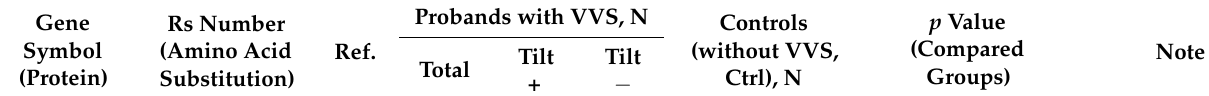
Table 1. Data on the association of polymorphic loci of candidate genes with vasovagal syncope